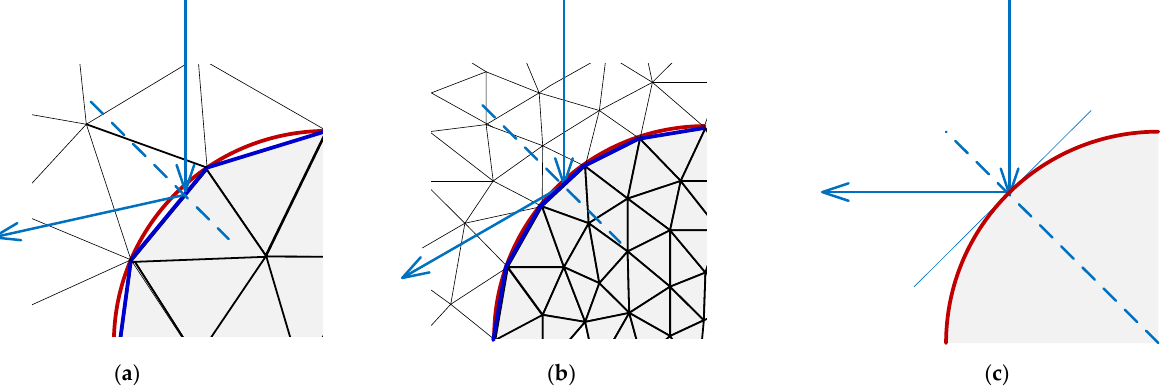
Figure 2. Photon reflection on vessel–dermis boundary. ( a ) Tetrahedron-based Monte Carlo method with extended boundary condition (TMCE) with relatively sparse mesh, ( b ) TMCE with refined mesh, and ( c ) real physical process.